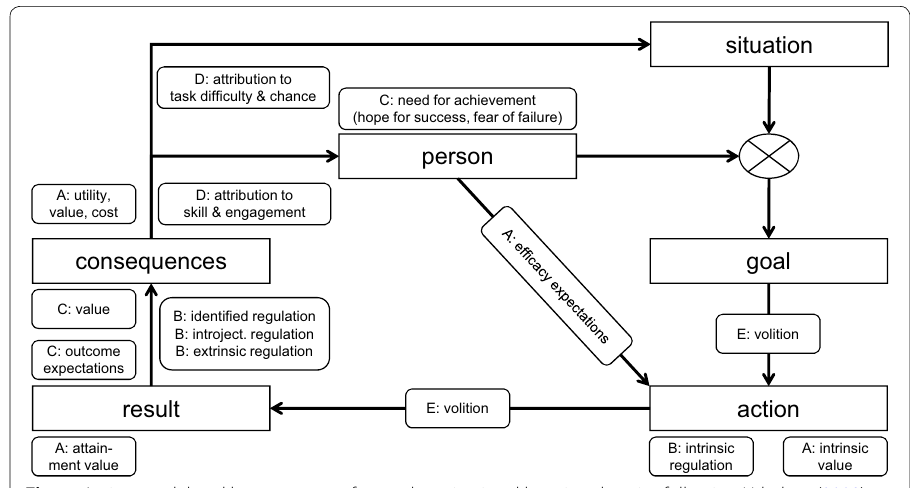
Fig. 1 Action model and key concepts of central motivational learning theories following Urhahne (2008)